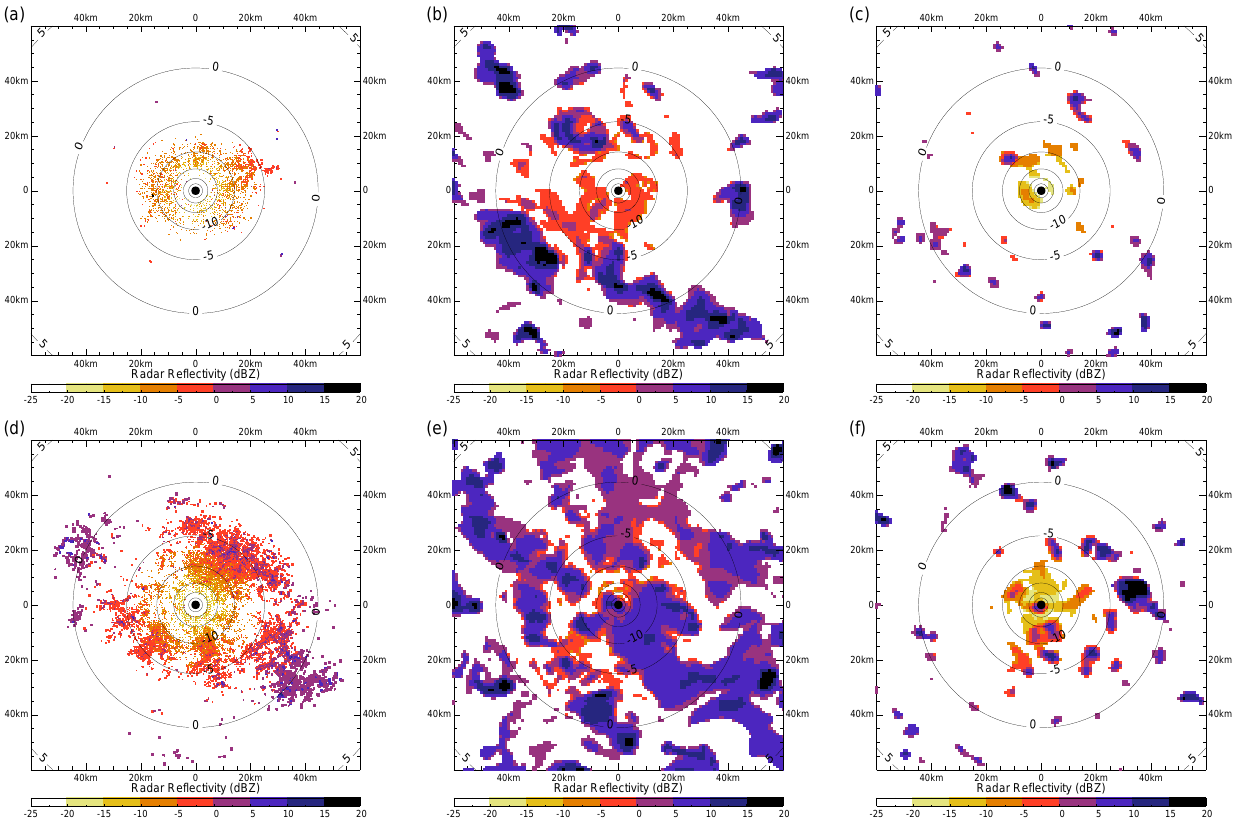
Fig. 8. Radar reflectivity from the C-band radar on the Ron Brown ( a and d ) with MetUM results from the 1 km control ( b and e ) and modified microphysics ( c and f ) simulations. The top row (a–c) shows 15:00 UTC on 12 November 2008 and the bottom row (d–f) 03:00 UTC on 13 November 2008. Each plot shows the maximum reflectivity in the column, and the circles show the minimum detectable reflectivity of the radar, for which the model plots are adjusted.